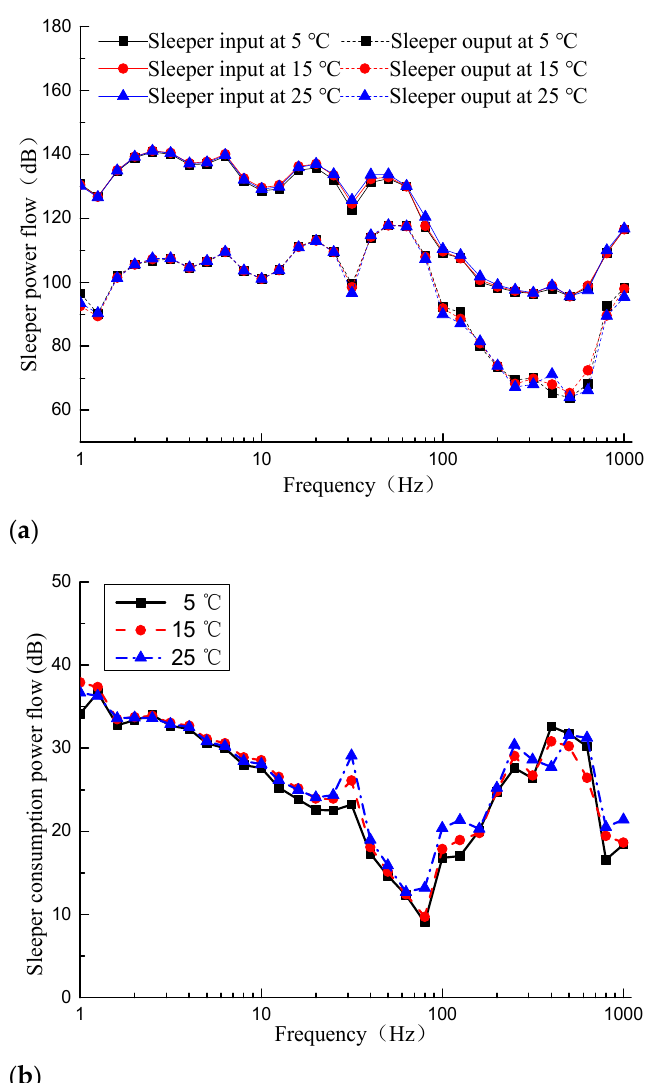
Figure 13. Sleeper power flow: ( a ) sleeper input and output power flow; ( b ) sleeper consumption power flow.